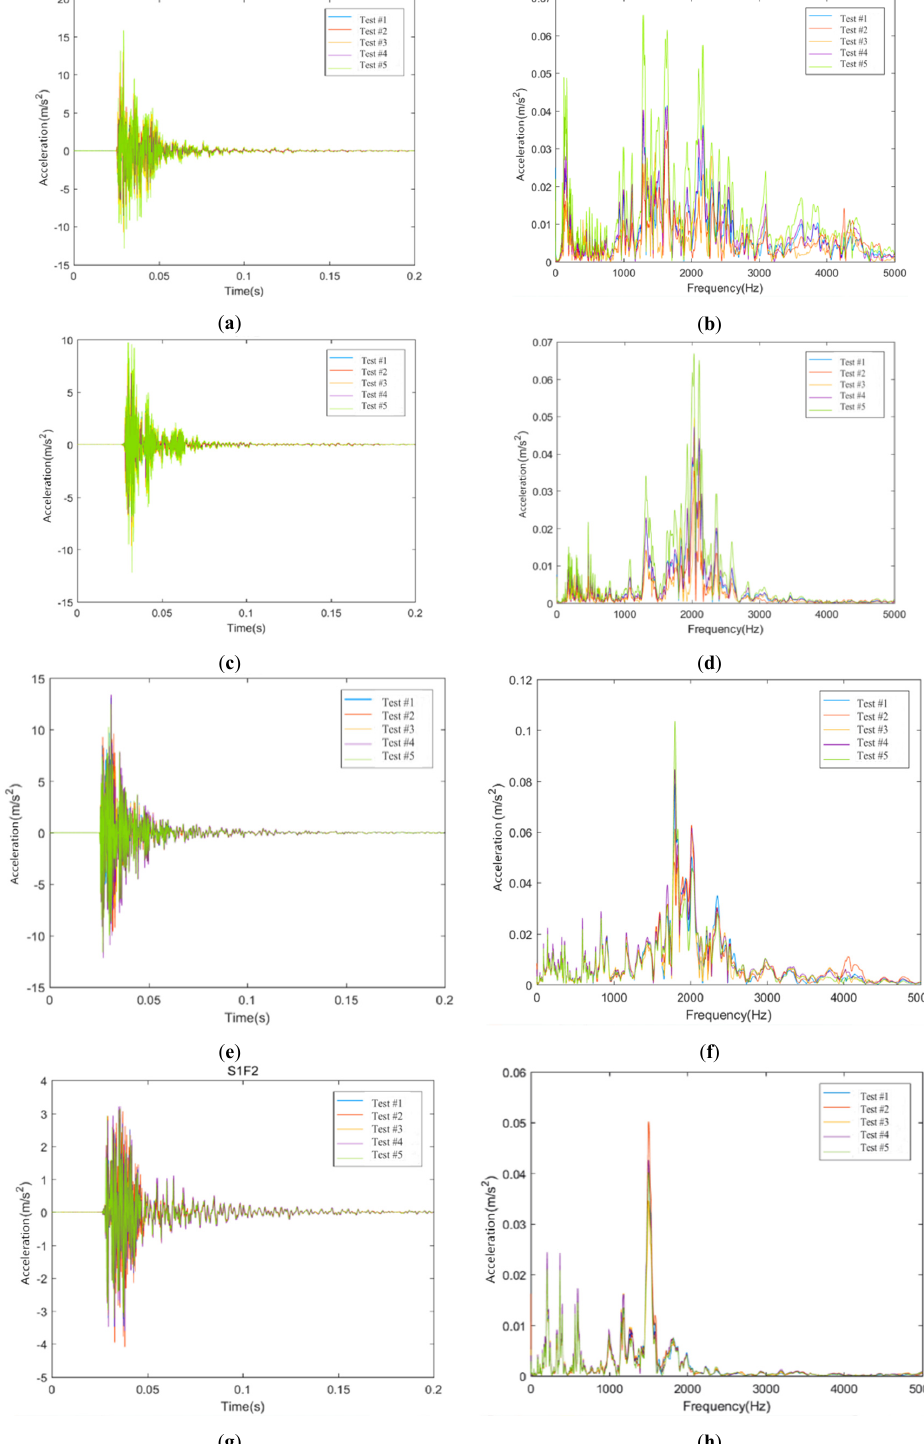
Figure 8. Vibration characteristics of track slabs. ( a ) Time-domain measuring data of sensor S1F1 in Condition #1; ( b ) Frequency-domain measuring data of sensor S1F1 in Condition #1; ( c ) Time-domain measuring data of sensor S1F2 in Condition #1; ( d ) Frequency-domain measuring data of sensor S1F2 in Condition #1; ( e ) Time-domain measuring data of sensor S1J1 in Condition #2; ( f ) Frequency-domain measuring data of sensor S1J1 in Condition #2; ( g ) Time-domain measuring data of sensor S1J2 in Condition #2; ( h ) Frequency-domain measuring data of sensor S1J2 in Condition